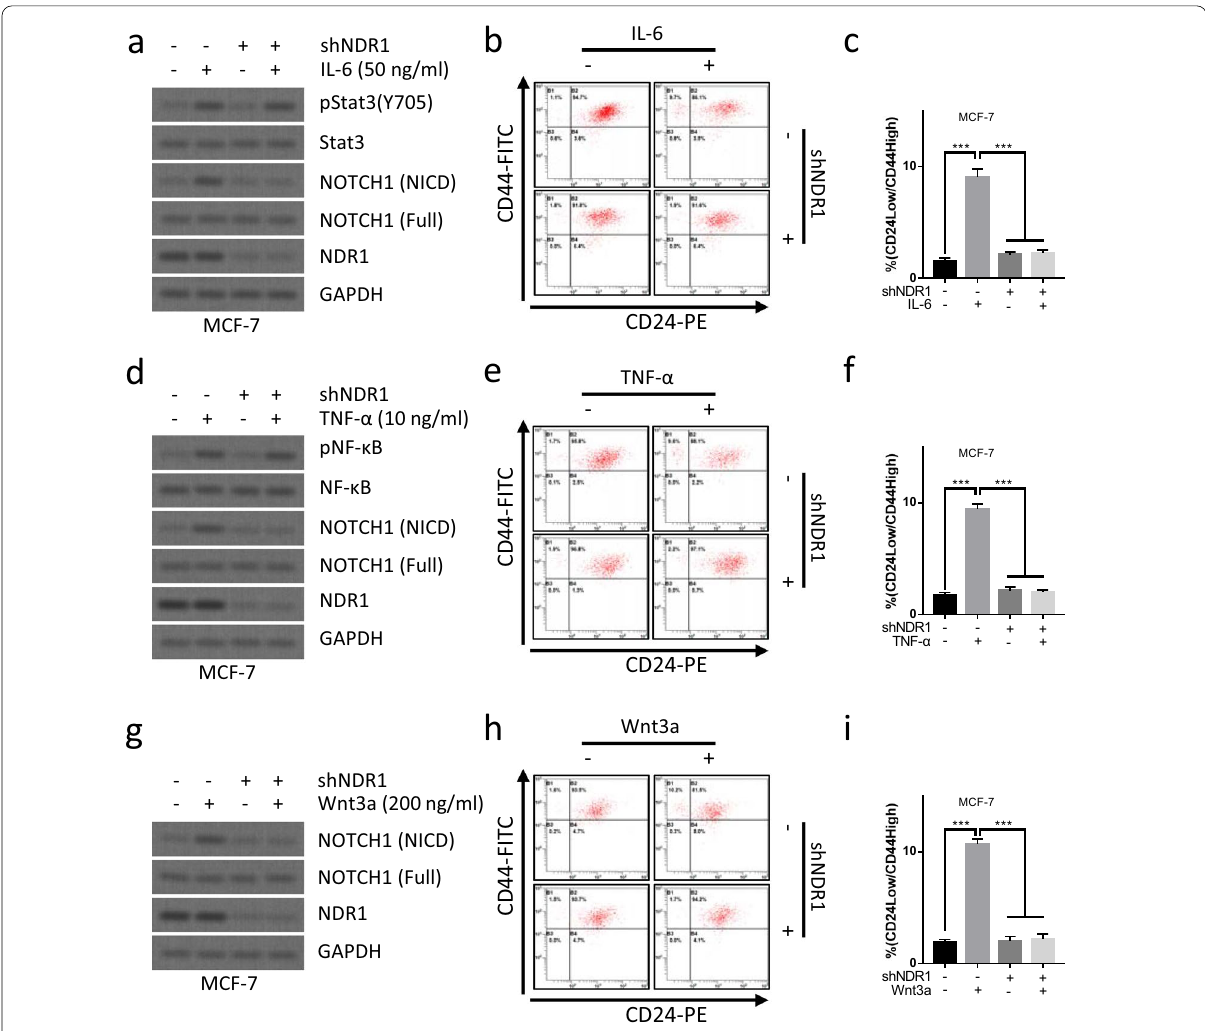
Fig. 6 NDR1 mediates IL‑6, TNF‑α or Wnt3a induced activation of Notch1 signaling pathway and enrichment of breast cancer stem cells . a – c MCF‑7 cells were treated with or without IL‑6 or shNDR1 for 7 days. The cell were collected for western blot analysis or CD24/44 analysis. d – f MCF‑7 cells were treated with or without TNF‑α or shNDR1 for 7 days. The cell were collected for western blot analysis or CD24/44 analysis. g – i MCF‑7 cells were treated with or without Wnt3a or shNDR1 for 7 days. The cell were collected for western blot analysis or CD24/44 analysis. The bar represents mean SD of three independent experiments (*: p < 0.05, **: p < 0.01, ***: p < ±